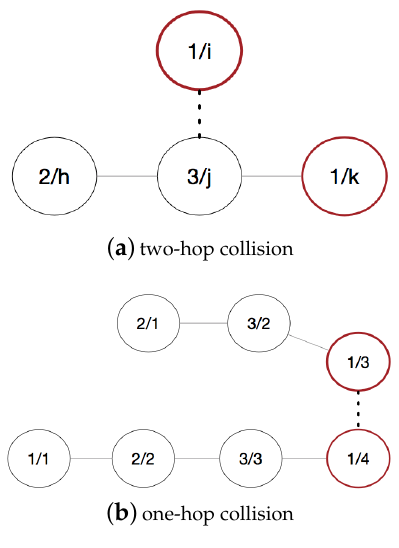
Figure 5. Collision model.